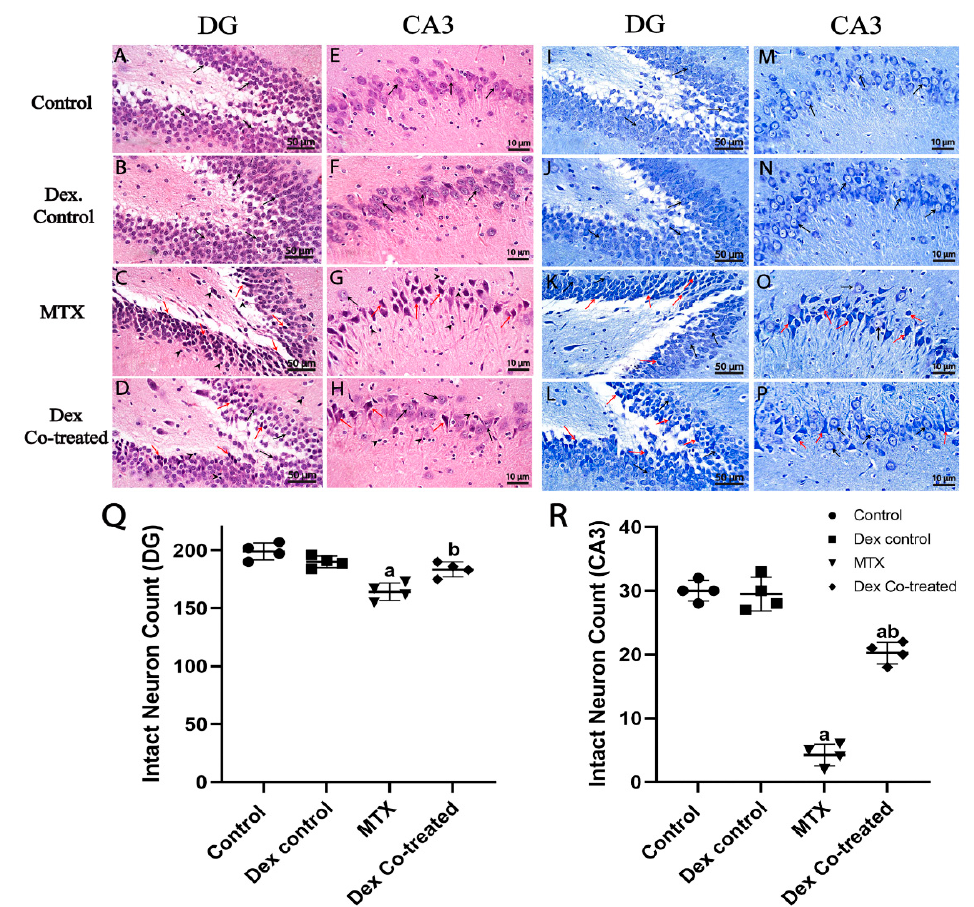
Figure 7. Hematoxylin and Eosin (H&E) and Nissl staining of hippocampus. ( A – H ) H&E staining, and ( A , B ) normal morphology with intact subcellular details (arrow). ( C ) shows higher degeneration of granule neurons with higher figures of nuclear pyknosis (red arrow) and higher reactive glial cell infiltrates (arrowhead). ( D ) shows almost the same records as MTX with mildly higher records of apparent intact granule cells. ( E , F ) normal morphology with intact well-organized pyramidal neurons and intact nuclear and subcellular details (black arrow). ( G ) severe neuronal loss and hypereosinophilic, angular necrotic pyramidal neurons without distinct subcellular details (red arrow) alternated with few scattered apparent intact cells (black arrow) and markedly higher-reactive microglial cell infiltrates (arrowhead). ( H ) moderate protective efficacy with persistent records of damaged and necrotic neurons (red arrow) alternated with higher records of apparent intact neurons (black arrow) and milder-reactive glial cell infiltrates (arrowhead). ( I–P ) Nissl staining showing intact neurons (black arrow) and damaged neurons (red arrow). ( Q ) Intact neu- ron count in DG. ( R ) Intact neuron count in CA3. Data are expressed as mean ± SD, n = 4. (a) Sig- nificant difference from control, and (b) significant difference from MTX. Significance level is set at p < 0.05. One-way ANOVA with Tukey’s post hoc test were used in the statistical analysis. (A,D) H&E 400×, (E,H) H&E 1000×, (I,L) Nissl staining 400×, (M,P) Nissl staining 1000×. We further employed Nissl staining to detect degraded and intact neuron count in the DG and CA3 hippocampal regions from all experimental groups (Figure 7I–P). All cells were counted in these two regions using a light microscope at 400X magnification. The MTX-treated rats showed a significant decrease in intact granule cells by nearly 16%